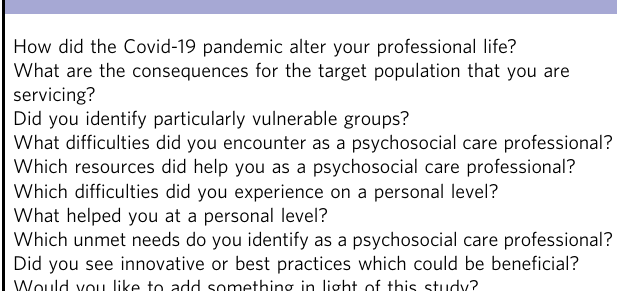
Table 2 List of 10 open-ended questions round 1 for